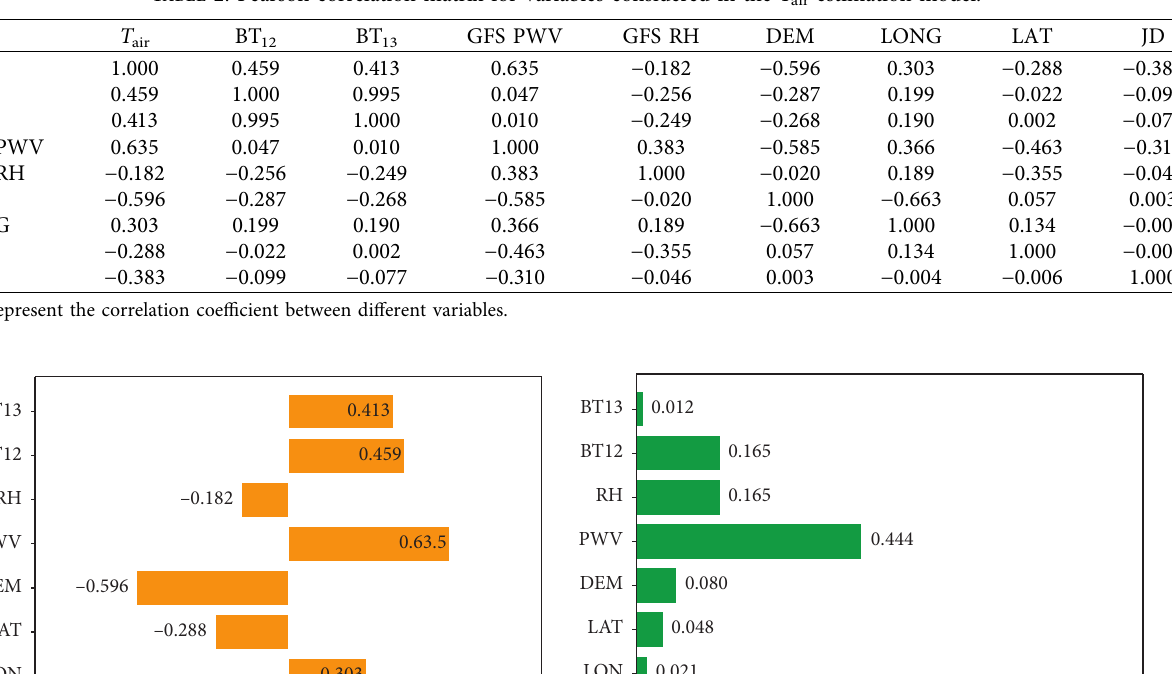
air estimation model.